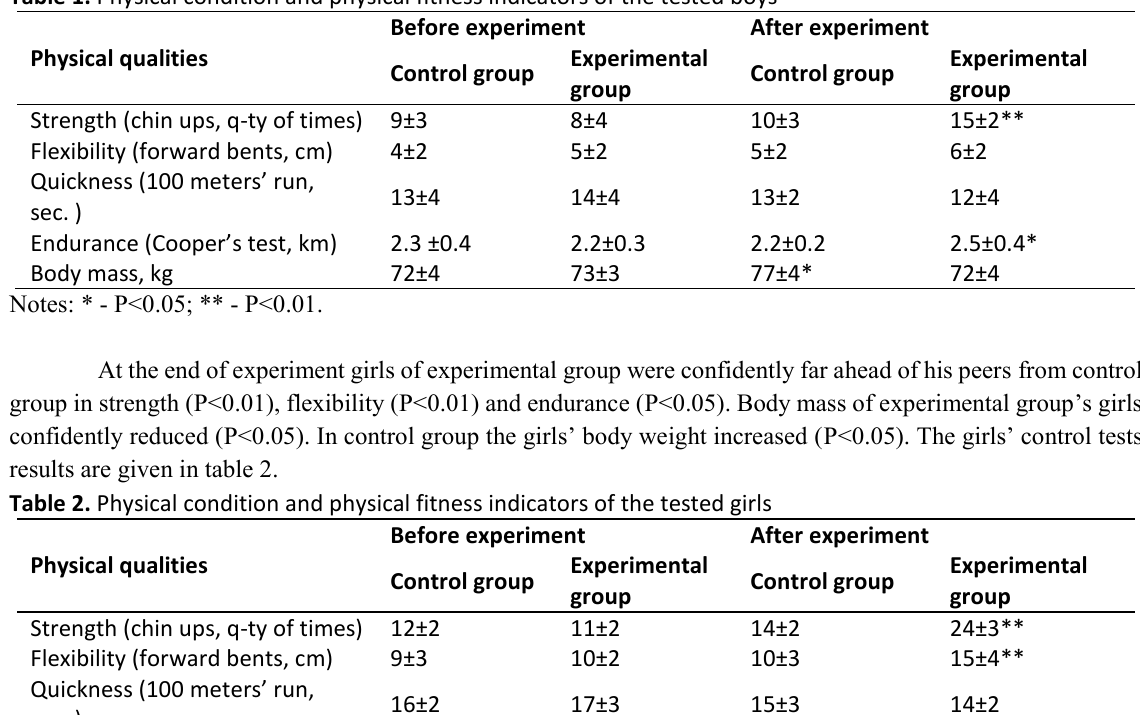
Before experiment After experiment Experimental Experimental Control group Control group group